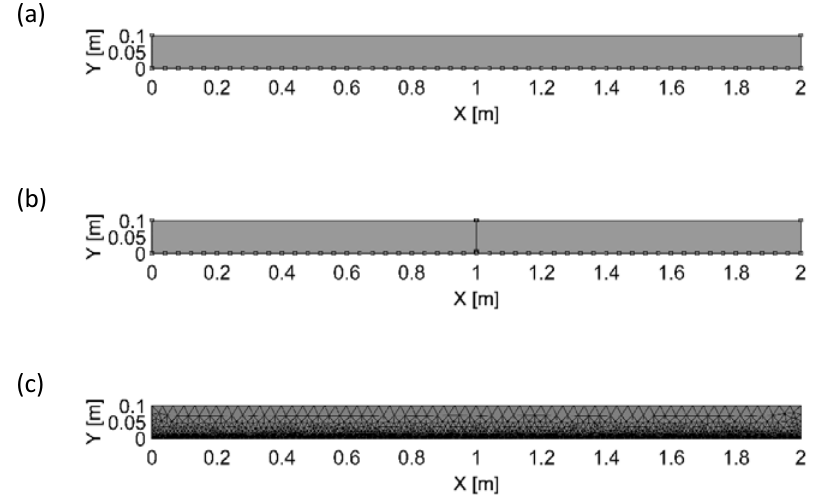
Figure 9. Lattice model geometry for (a) un ‐ cracked beam, (b) cracked beam, and (c) mesh. After [46].